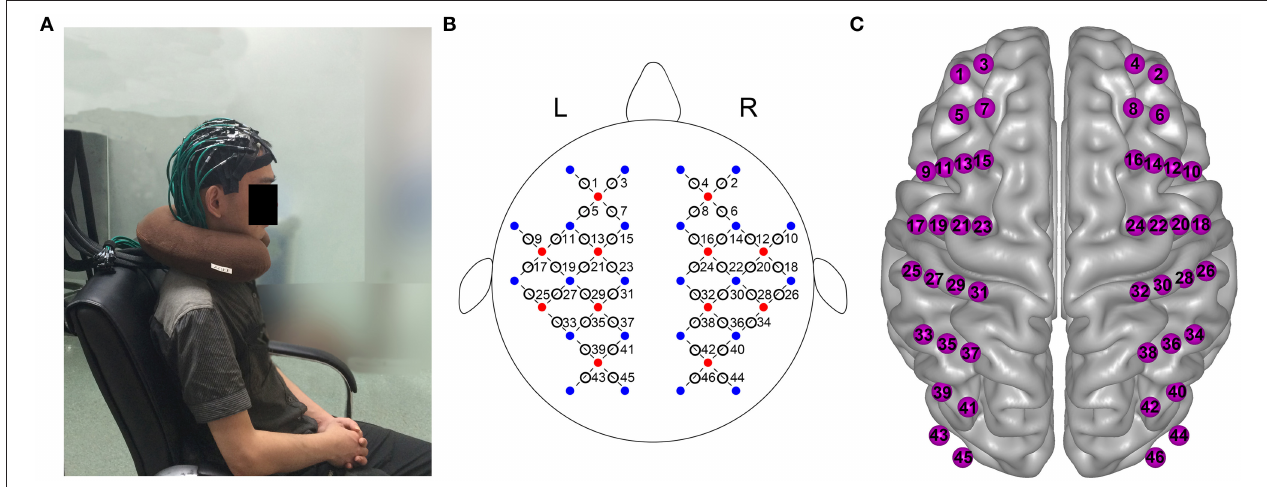
FIGURE 1 | Whole-head fNIRS measurement. (A) Photograph of whole-head fNIRS measurement on participant. (B) The schematic of whole-head imaging pad (12 sources, red, 24 detectors, blue). The sources and detectors were symmetrically placed on the left and right hemispheres and constituted 46 measurement channels, which allowed for the whole brain (i.e., frontal, temporal, parietal, and occipital lobes) to be measured. (C) Anatomical position of each measurement